Question: Summarize what this figure shows in one sentence.
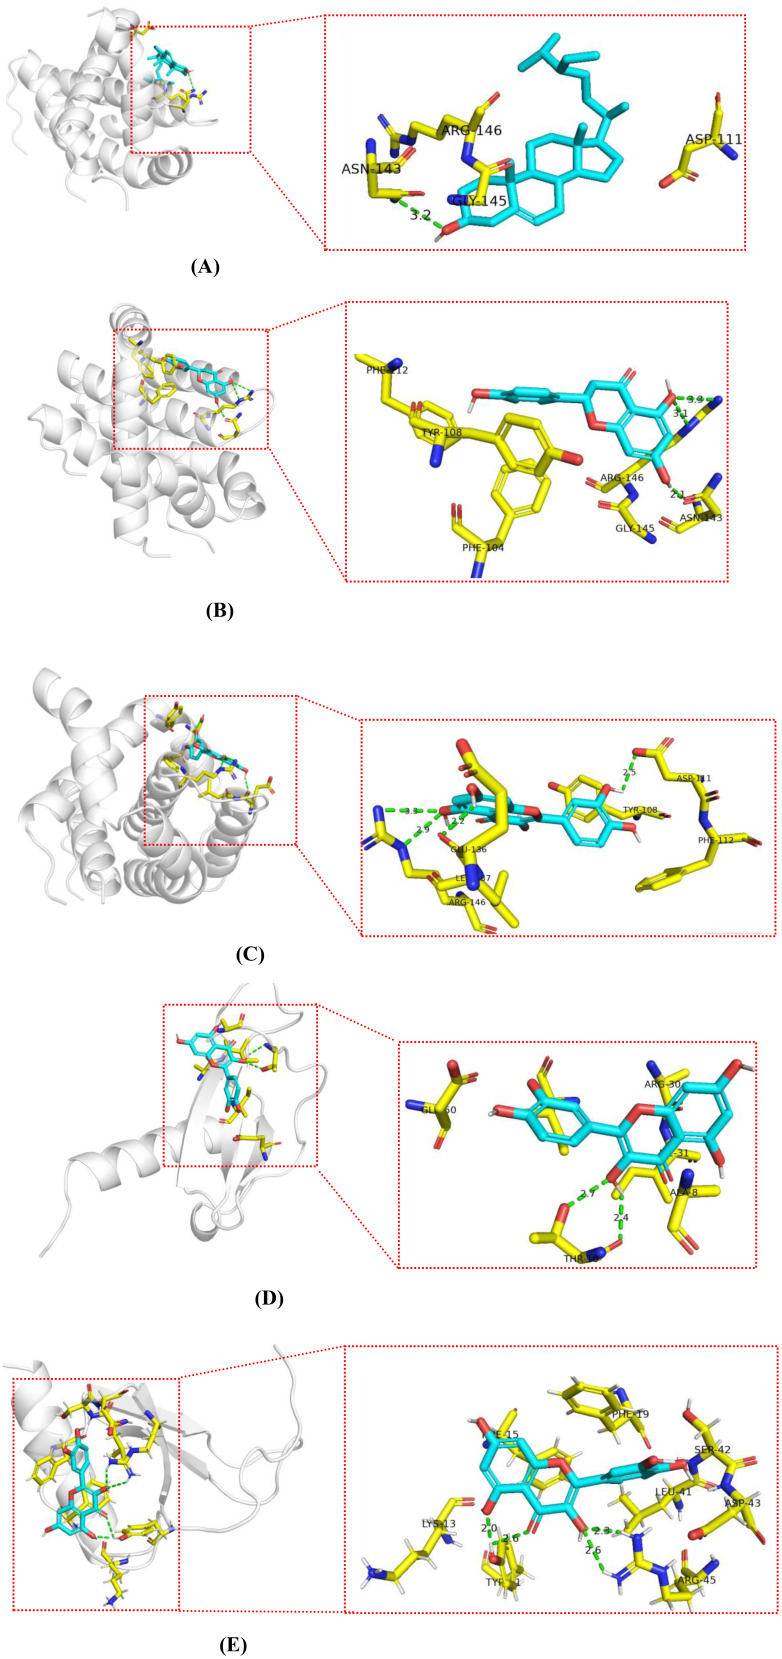
Answer: Molecular docking results (Tufuling-Huangbo). (A) Molecular docking of BCL2 with beta-sitosterol. (B) Molecular docking of BCL2 with naringenim. (C) Docking plot of BCL2 with quercetin. (D) Docking of CCL2 with quercetin. (E) Docking of CXCL8 with quercetin.